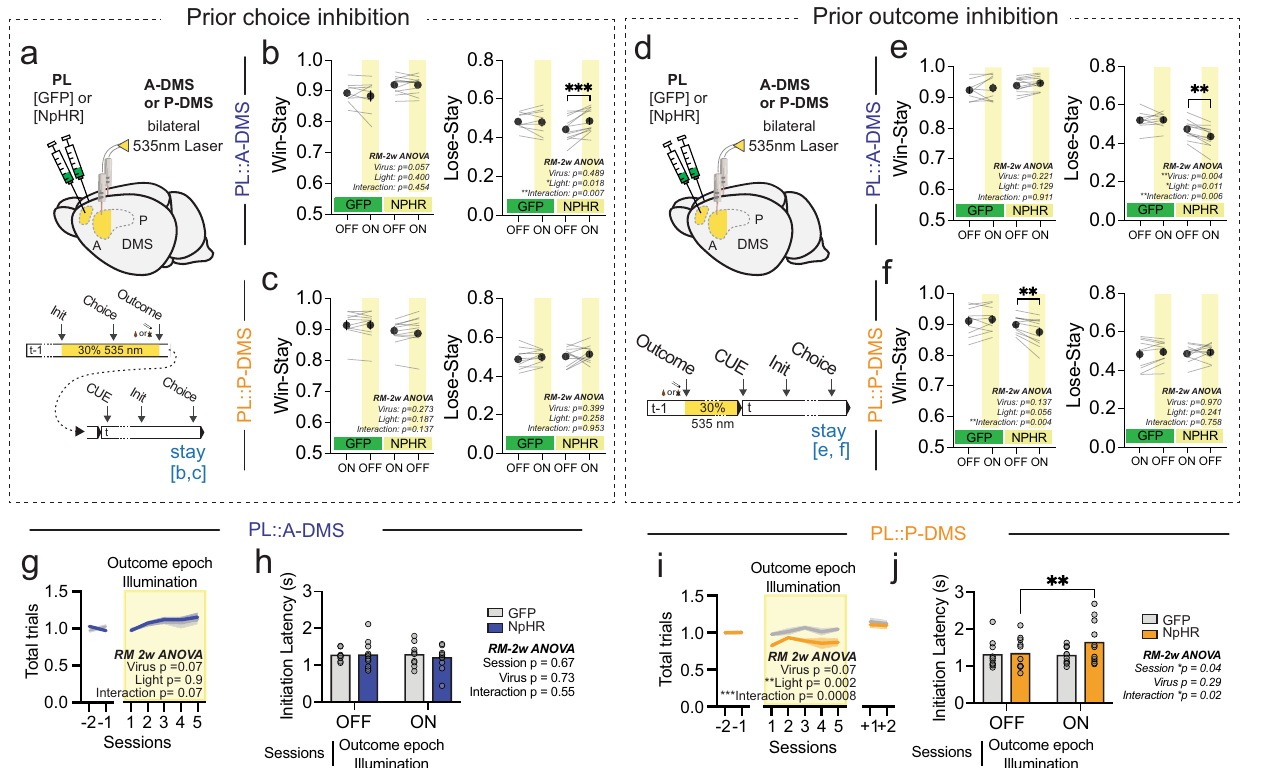
Fig. 8 | Optogenetic suppression during choice/outcome epoch impaired subsequent choice selection in a pathway-speci fi c manner. a Schematic of surgery for pathway speci fi c suppression and light delivery protocol for prior choice inhibition. b Changes in Win-stay ( left ) and Lose-stay ( right ) probabilities when light was ON versus OFF during choice on prior trials for PL::A-DMS circuits infected with either GFP or NpHR (black, mean ±SEM; light gray line, each animal). Yellowboxindicateslightdeliveredonpriorchoiceepoch(GFP n =9animals,NpHR n =12 animals, Š idák multiple comparison test). *** p <0.001. c same as b, but for PL::P-DMS circuits (GFP n =10 animals, NpHR n =11 animals). d Schematic of sur- geryforpathwayspeci fi csuppressionandlightdeliveryprotocolforprioroutcome inhibition. e ChangesinWin-stay( left )andLose-stay( right )probabilitieswhenlight was ON versus OFF after outcome on prior trials for PL::A-DMS circuits infected with either GFP or NpHR (black, mean ± SEM; light gray line, each animal). Yellow